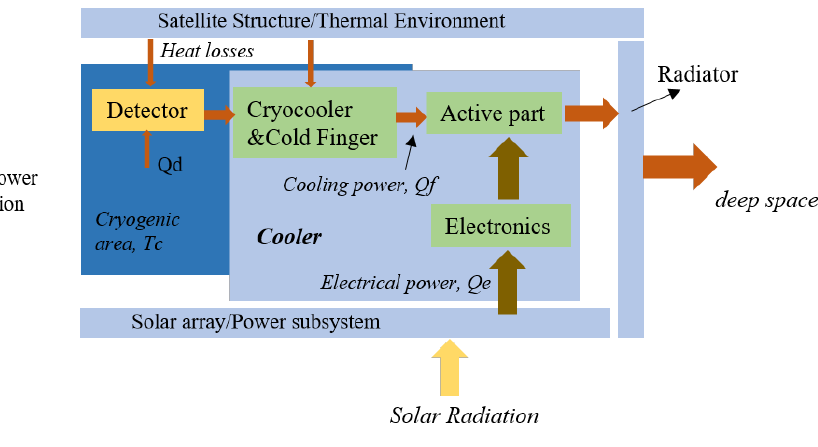
Figure 1. Payload